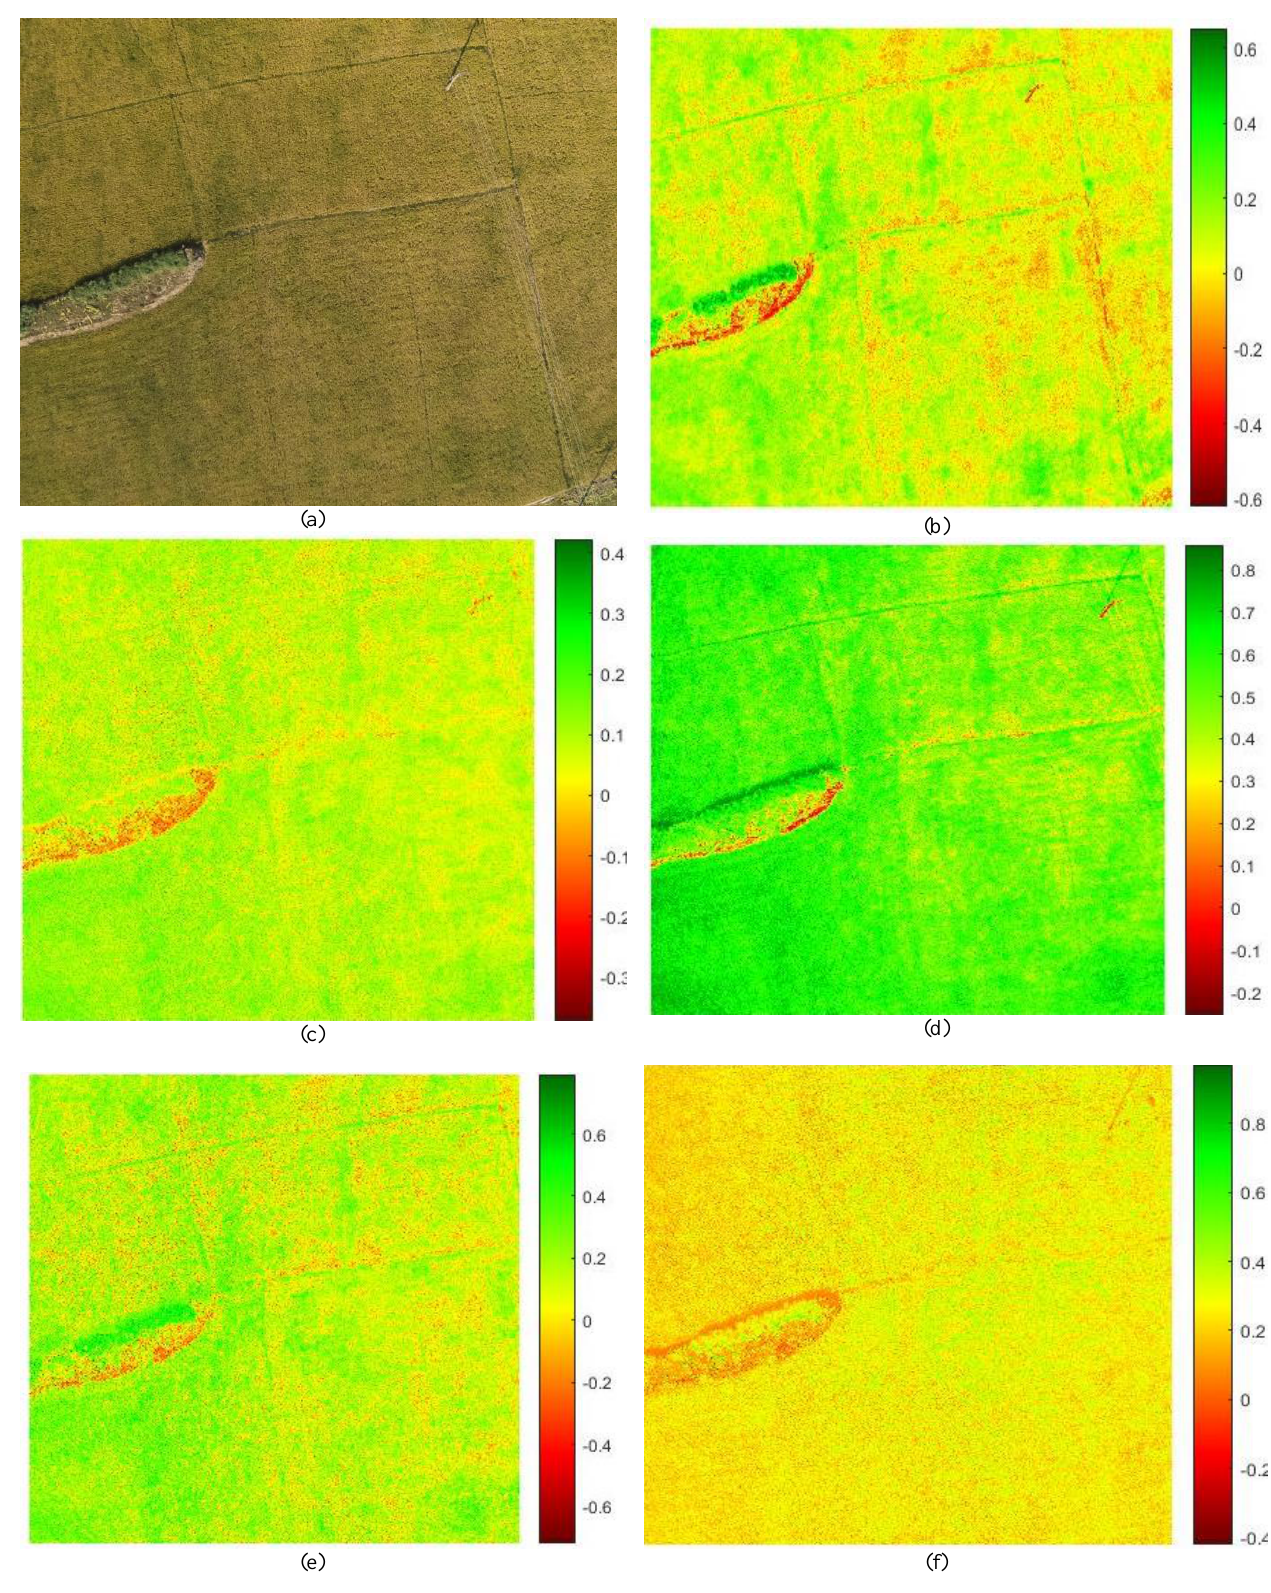
Figure 5. RGB image and calculated indices of a UAV image covering rice